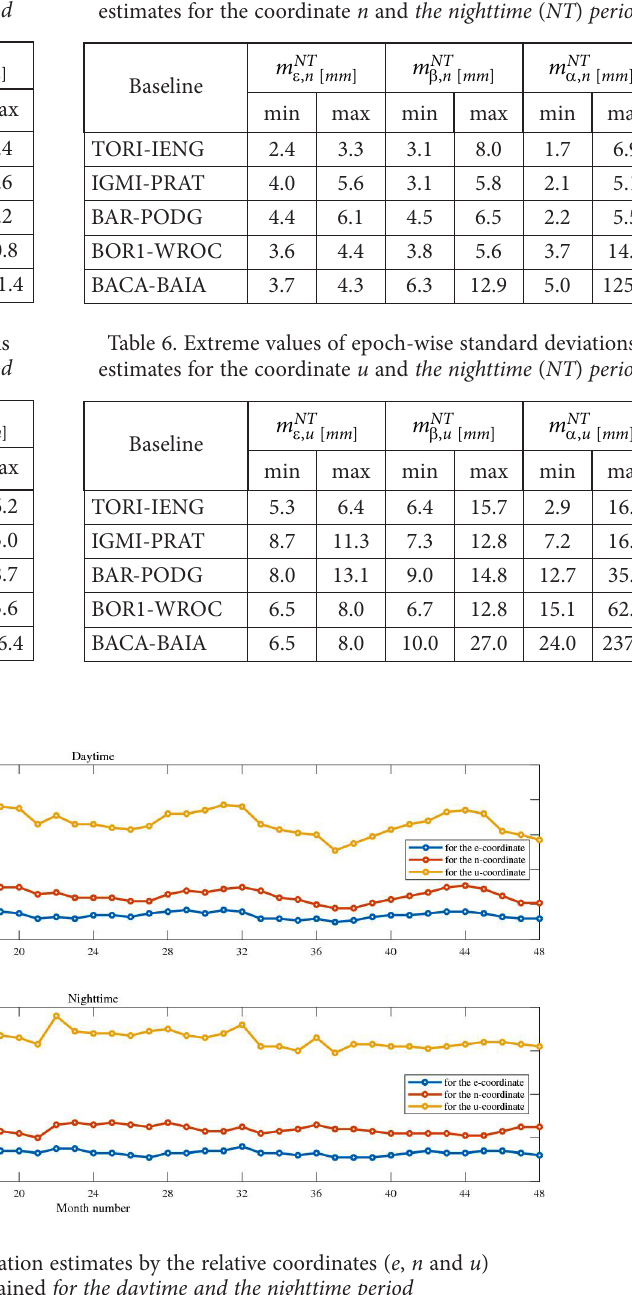
Table 5. Extreme values of epoch-wise standard deviations